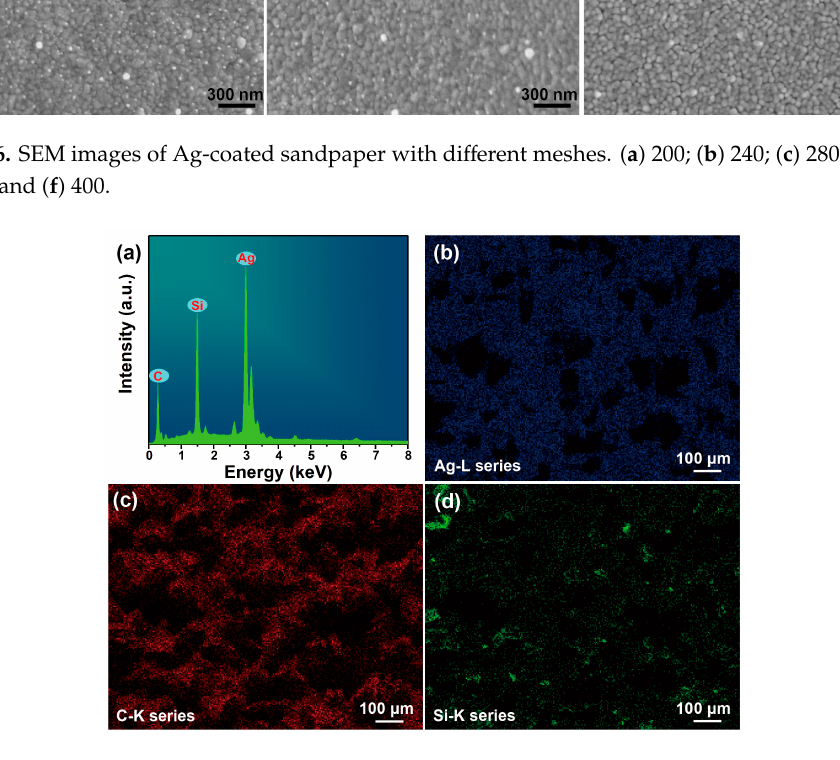
Figure 8. ( a ) The SERS spectra from the Ag-coated sandpaper with different mesh; ( b ) The SERS intensities at 1078 cm − 1 from 20 random test dots on the Ag-coated sandpaper (240 mesh); ( c ) SERS spectra of 4MBA with different concentration and Raman spectra of 4MBA power; ( d ) The corresponding dose-response curve of the peak intensity at 1078 cm − 1 . Additionally, to probe into the cycling efficiency and stability of nanocomposites in immunoassay, the detection and photocatalytic eliminating of PSA were carried out six times, as illustrated in Figure 9a. The appearance of strong SERS signals after the immunoassays (1 to 6), and their removing after UV illumination (1’ to 6’), were successfully proven. The drift in the SERS intensity by 20% after 6 cycles of immunoassay and photocatalytic reaction can be visualized in Figure 9b, which verifies the limited cycle times for maintaining enough enhancement ability. The performance of the immune structure in the recyclable detection of PSA with diluted concentration was further investigated. As shown in Figure 9c, the intensity of SERS spectra decreases by degrees with the reduction of PSA. Then, a standard curve for the recyclable detection of PSA is plotted in Figure 9d, which is primarily based on the intensity of 4MBA at 1078 cm − 1 against the logarithm of PSA concentration over the range of 10 − 4 to 10 − 12 g/mL, showing an admirable correlation (R 2 = 0.987).